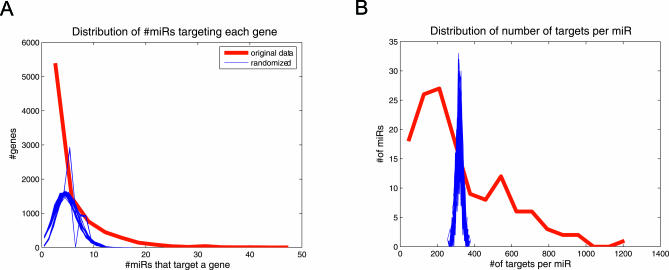
miRs and Target Genes in the TargetScan Dataset(A) Distribution of the number of different miRs regulating each target gene in the TargetScan dataset. The thick red line represents the distribution in the original datasets, while each of the thin blue lines represents the distribution in one of the column-randomized matrices. The matrix contains only genes with at least one predicted site in their 3′ UTR. In each randomization, we shuffled the assignment of miRs to their targets, keeping constant the number of targets per miR.(B) Distribution of number of targets per miR in the TargetScan dataset. In the thick red line we depicted the original distribution, while each blue thin line represents the distribution in one of the 100 row-randomized matrices, which preserve the distribution of number of miRs targeting each gene.